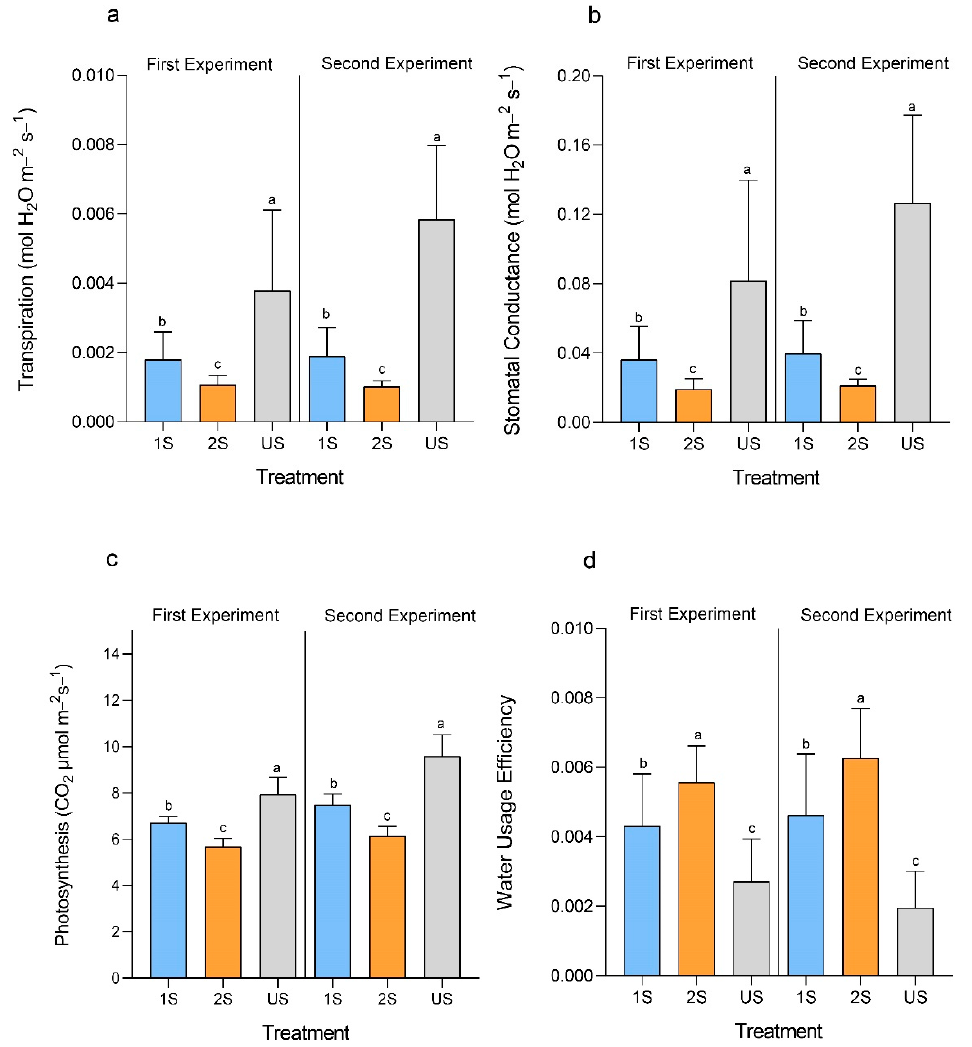
Figure 4. Changes in the photosynthesis-related parameters of primed (2S) and unprimed (1S) soybean C08 plants under drought treatment compared to the unstressed control (US). ( a ) Rate of transpiration, n = 12 plants. ( b ) Stomatal conductance, n = 12 plants. ( c ) Rate of photosynthesis, n = 12 plants. ( d ) Water usage efficiency, n = 12 plants. Error bars indicate standard deviation. Wilcoxon rank-sum test was used to compare between the mean values of each treatment following one-way ANOVA. Different letters above the bars indicate significant differences between groups at p < 0.05.